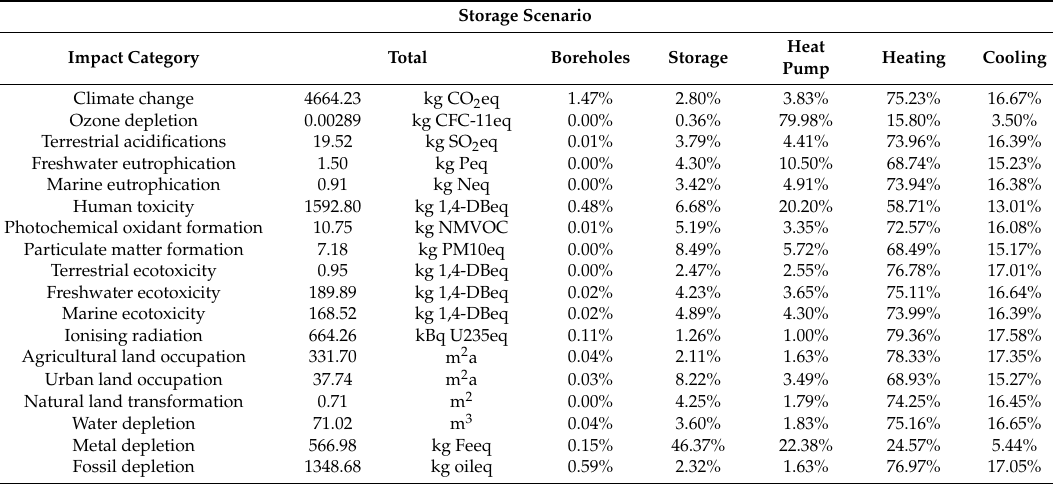
Table 5. Midpoint impact indicators for storage